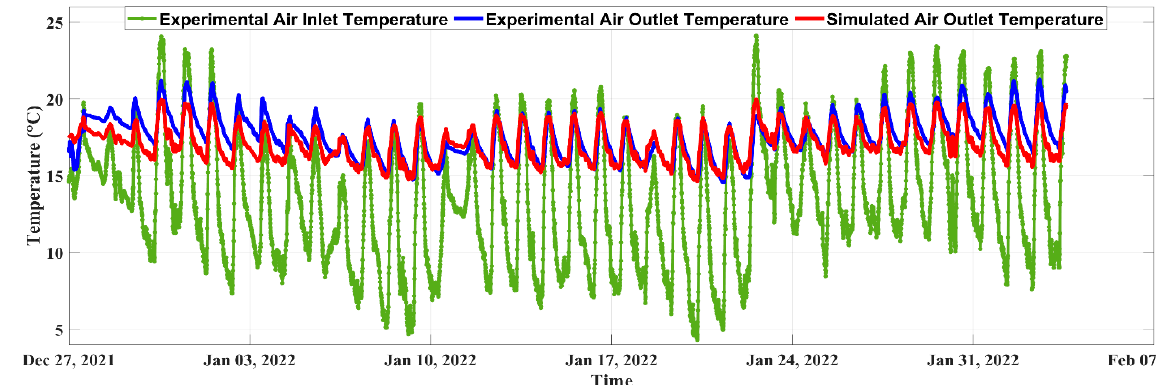
Figure 16. Experimental and simulation results of the deployed EAHE system (27 December 2021 to 2 February 2022).